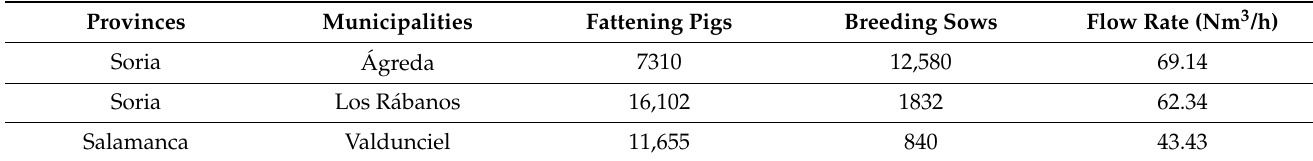
Table 8. Farms in which Membrane Separation upgrading can be